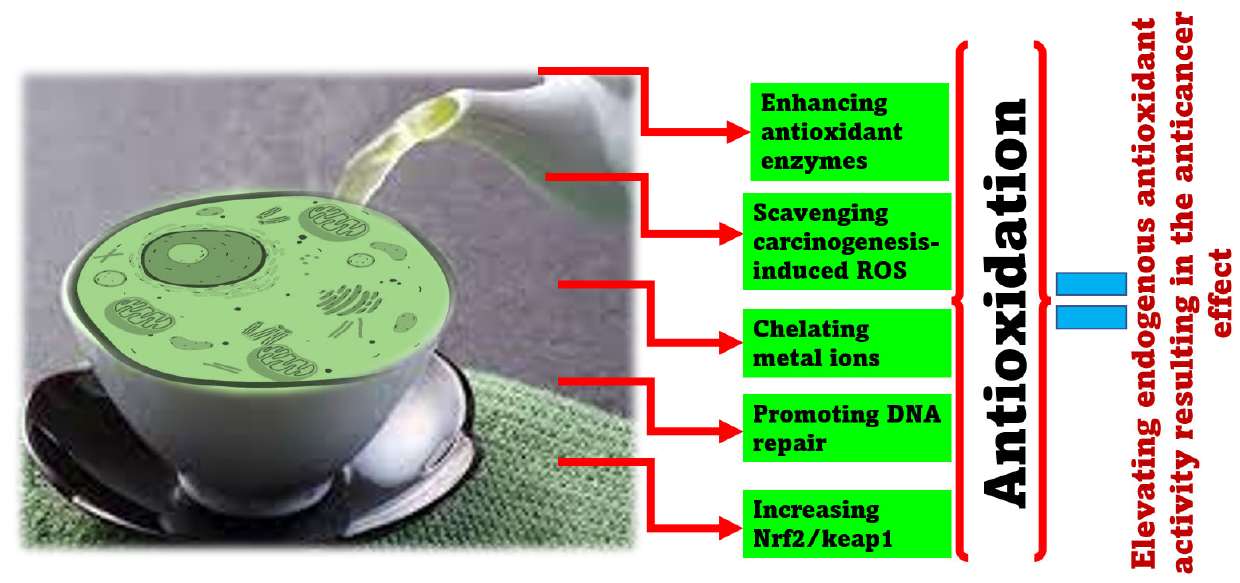
Figure 4. The molecular targets and signaling pathways are affected via the antioxidant activity of GTCs resulting in the anticancer effect.